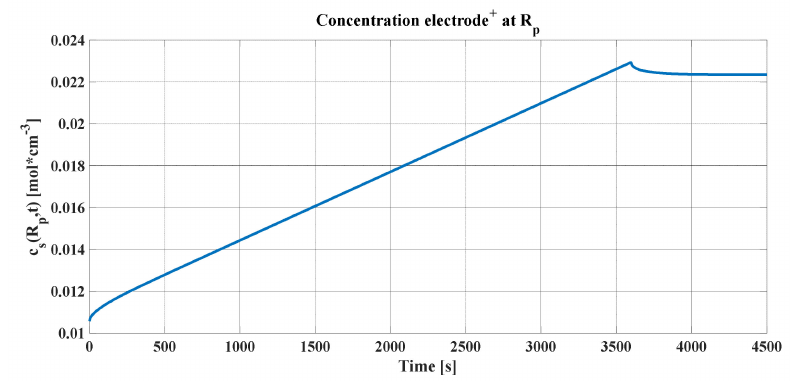
Figure 7. Concentration (Li + ) on the surface of the positive electrode